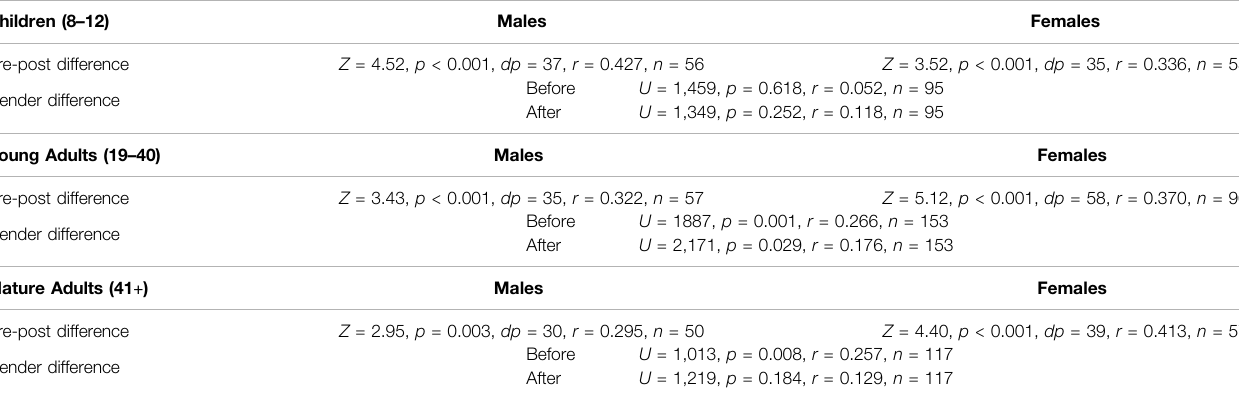
TABLE 4 | Statistical signi fi cance of differences of correct answers (medians) in scienti fi c content knowledge before (B) and after (A) the visit by gender and age group in T ū hura. Children (8 – 12)